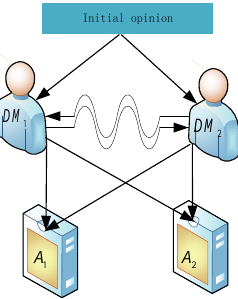
Figure 4. Quantum decision process of assessing two alternatives.